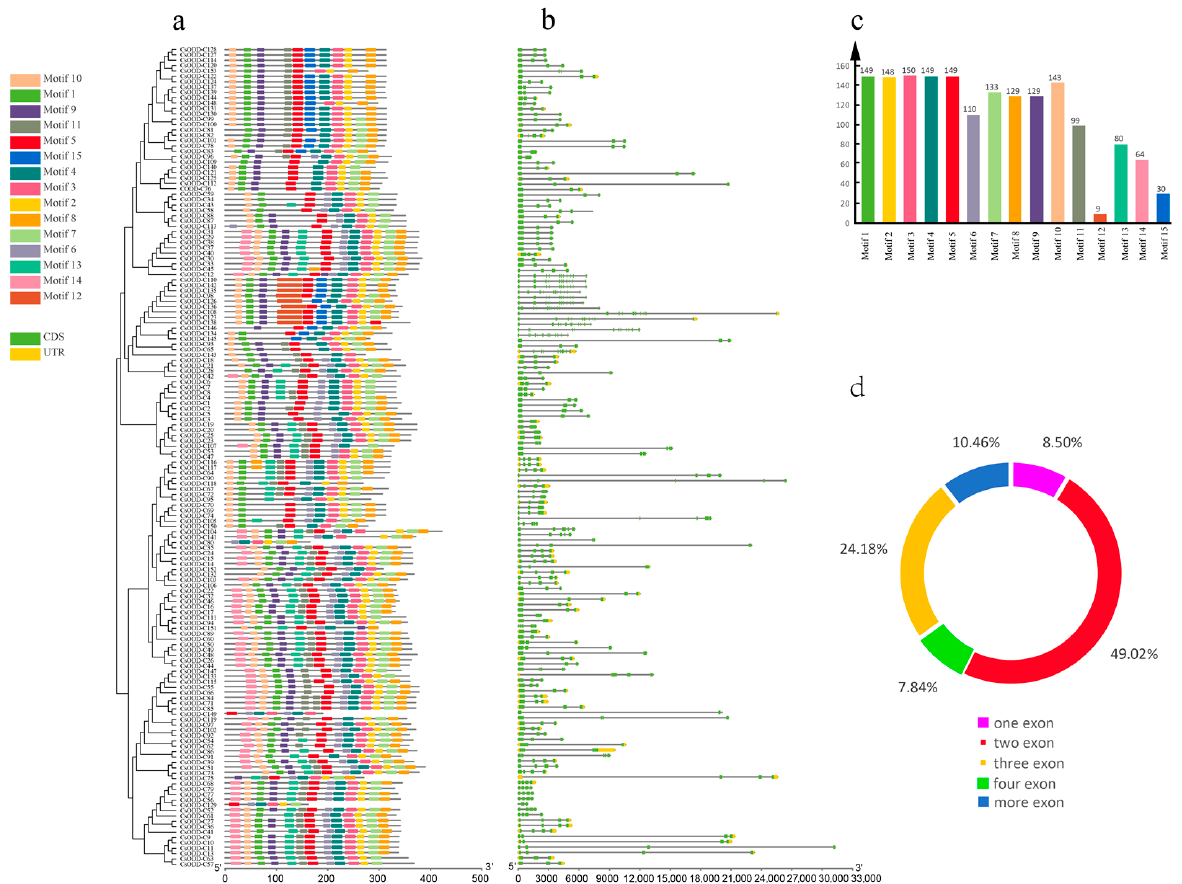
Figure 3. A schematic diagram of conserved motif and gene structure of the Cs2ODD − C gene family. ( a ) The conserved motifs of Cs2ODD − C proteins were conducted using the MEME online program, as described in Section 5. ( b ) The intron and exon structures of the Cs2ODD − C genes were obtained by Perl scripts and visualized by GSDS software. ( c ) Statistical analysis of the number of conserved motif distributions in Cs2ODD-C proteins. ( d ) The proportion of the Cs2ODD − C genes with different introns.